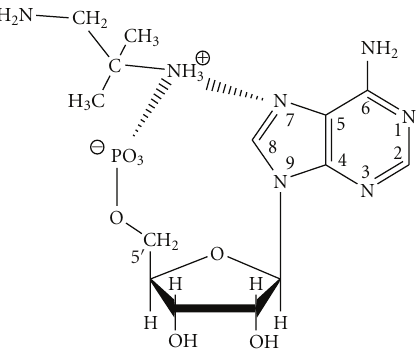
Figure 4: Tentative mode of interaction in the (AMP)H(tn-2)